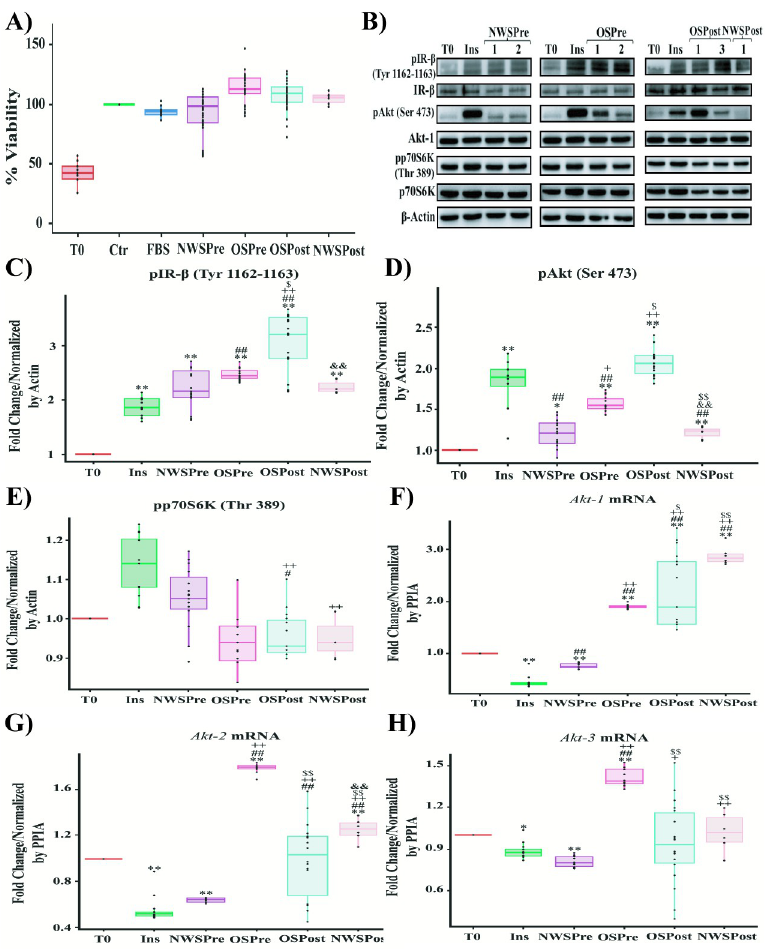
Fig 3. Effect on the viability and activation of the IR- β /Akt/p70S6K pathway of MCF-7 cells by stimulation with human sera from normal-weight and obese women with different hormonal states. A) Viability of MCF-7 cells exposed to sera from women with different BMIs and hormonal states. B) Western Blot of IR- β /Akt/p70S6K pathway members on MCF-7 cells exposed to sera from women with different BMIs and hormonal states. C) Group analysis of densitometric quantification stratified by serum condition of pIR- β (Tyr 1162–1163). D) Group analysis of densitometric quantification stratified by serum condition of pAkt (Ser 473). E) Group analysis of densitometric quantification stratified by serum condition of pp70S6K (Thr 389). F) Akt-1 expression levels on MCF-7 cells stimulated with human sera. G) Akt-2 expression levels on MCF-7 cells stimulated with human sera. H) Akt-3 expression levels on MCF-7 cells stimulated with human sera. For viability assay, the MCF-7 cells were treated with 10% inactivated fetal bovine serum (Ctr), 5% FBS, sera from normal-weight premenopausal women (NWSPre), sera from obese premenopausal women (OSPre), sera from obese postmenopausal women (OSPost) or sera from normal- weight postmenopausal women (NWSPost). For Western Blot test the cells were stimulated with recombinant human insulin (Ins) (0.5 UI/ml) (positive control for activation of the IR- β /Akt pathway) or 5% NWSPre, OSPre, OSPost or NWSPost. Labels of Western Blot as described in Fig 2. RT-PCR for Akt isoforms: Akt-1, Akt-2, Akt-3, and peptidylprolyl isomerase A (PPIA) as constitutive control. Western blot armed image. All experiments were carried out in triplicate (n = 9) for each serum evaluated. Comparison of means �� P < 0.005, � P < 0.05. �� Ctr or T0, ## 5% FBS or Ins, ++ NWSPre, $ $ OSPre, &&